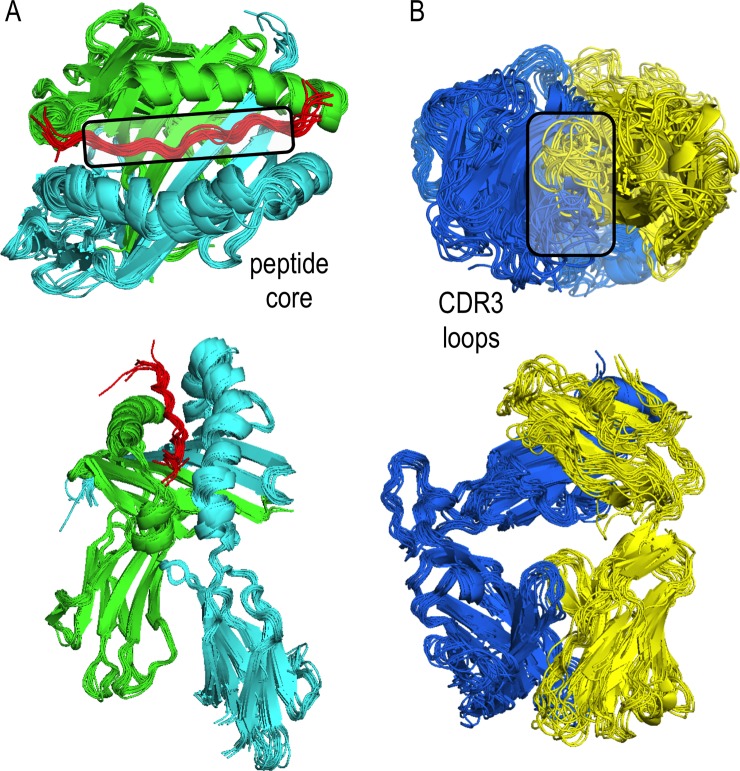
A) Structural alignment of pMHCII complexes from the benchmark set. Alpha and beta chains are green and cyan, respectively. The peptide is shown in red with its core region in the box. B) Structural alignment of TCRs from the benchmark set. TCR alpha and beta chains are shown in yellow and blue, respectively. The variable TCR CDR3 loops are shown in the box. To address TCR loop variability, 10 models are used for each TCR sequence.